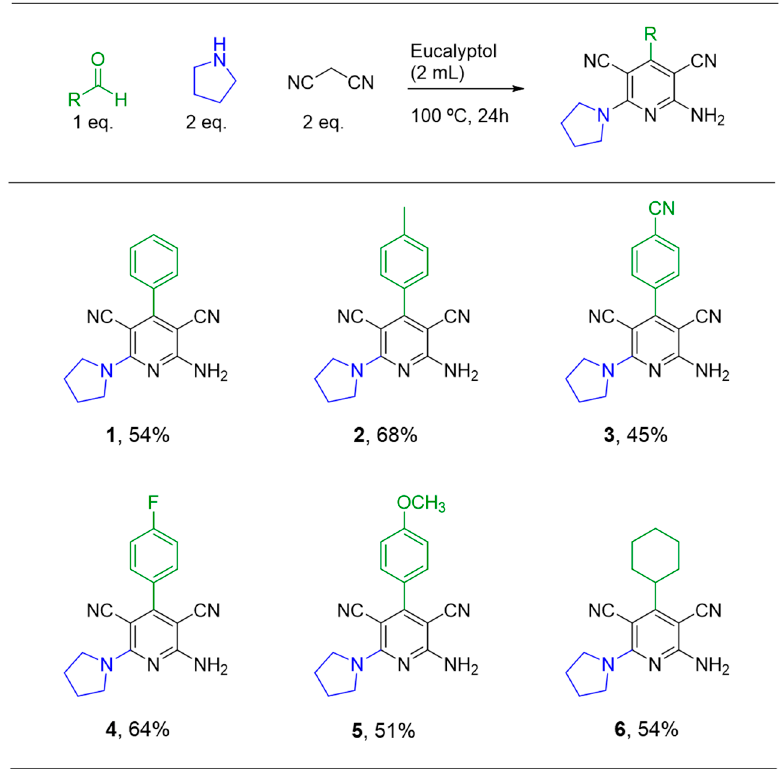
Figure 3. Scope and limitations of multicomponent reaction for the synthesis of highly functional- ized pyridines.